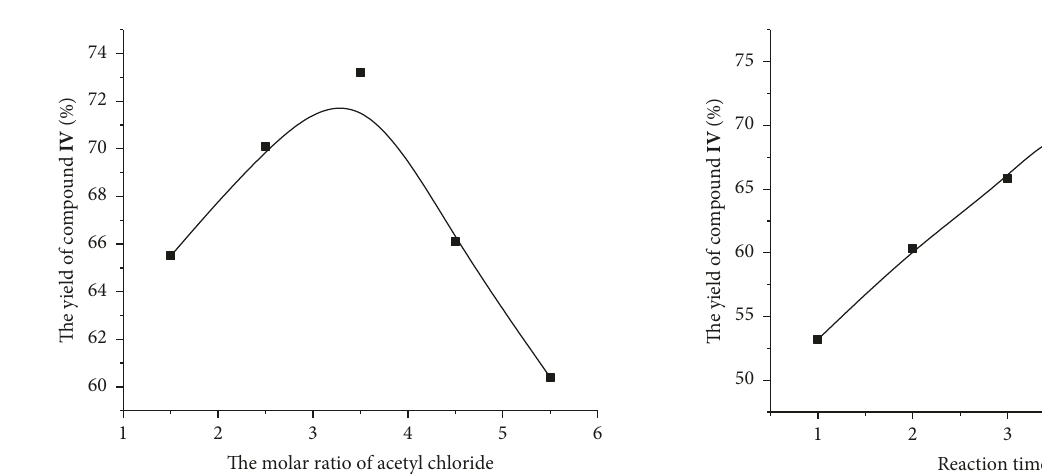
Figure 10: Impact of reaction time. Table 2: The results of central composite design-response surface methodology.